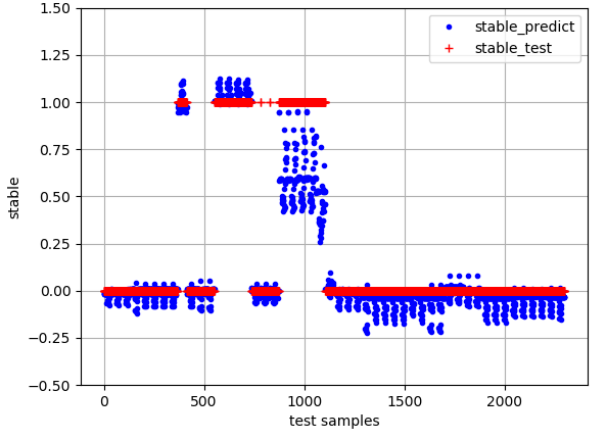
Figure 6. Stability prediction results of the test set after optimization (the first 100 cycles).